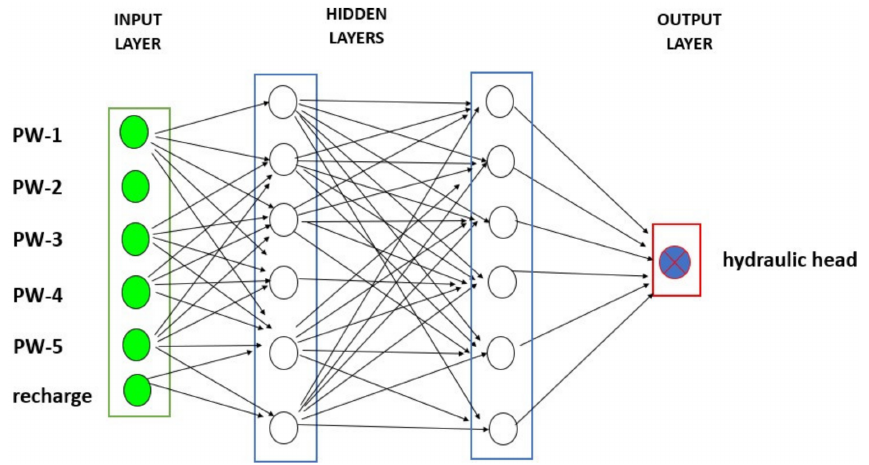
Figure 4. Deep feedforward neural network architecture used for learning the mapping between hydrologic stresses (pumping and recharge) and hydraulic head.